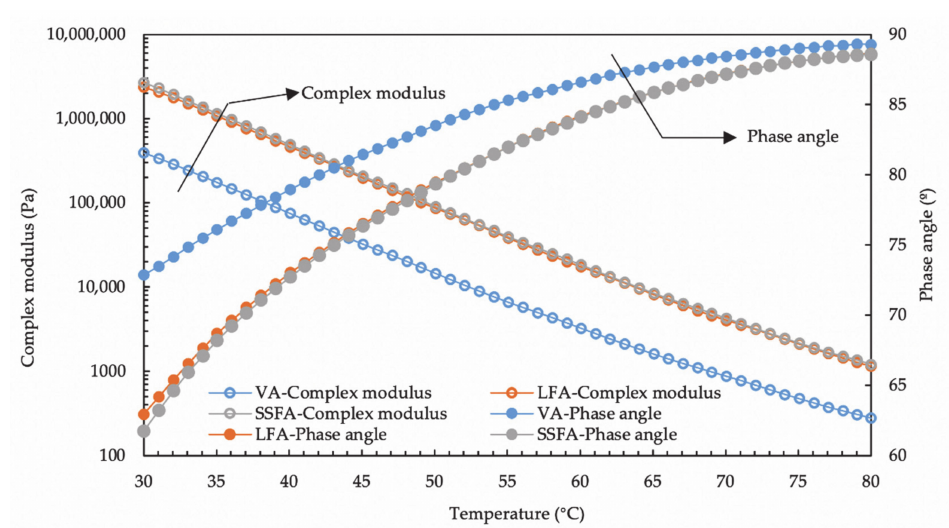
Figure 5. Temperature sweep analysis of VA, SSFA and